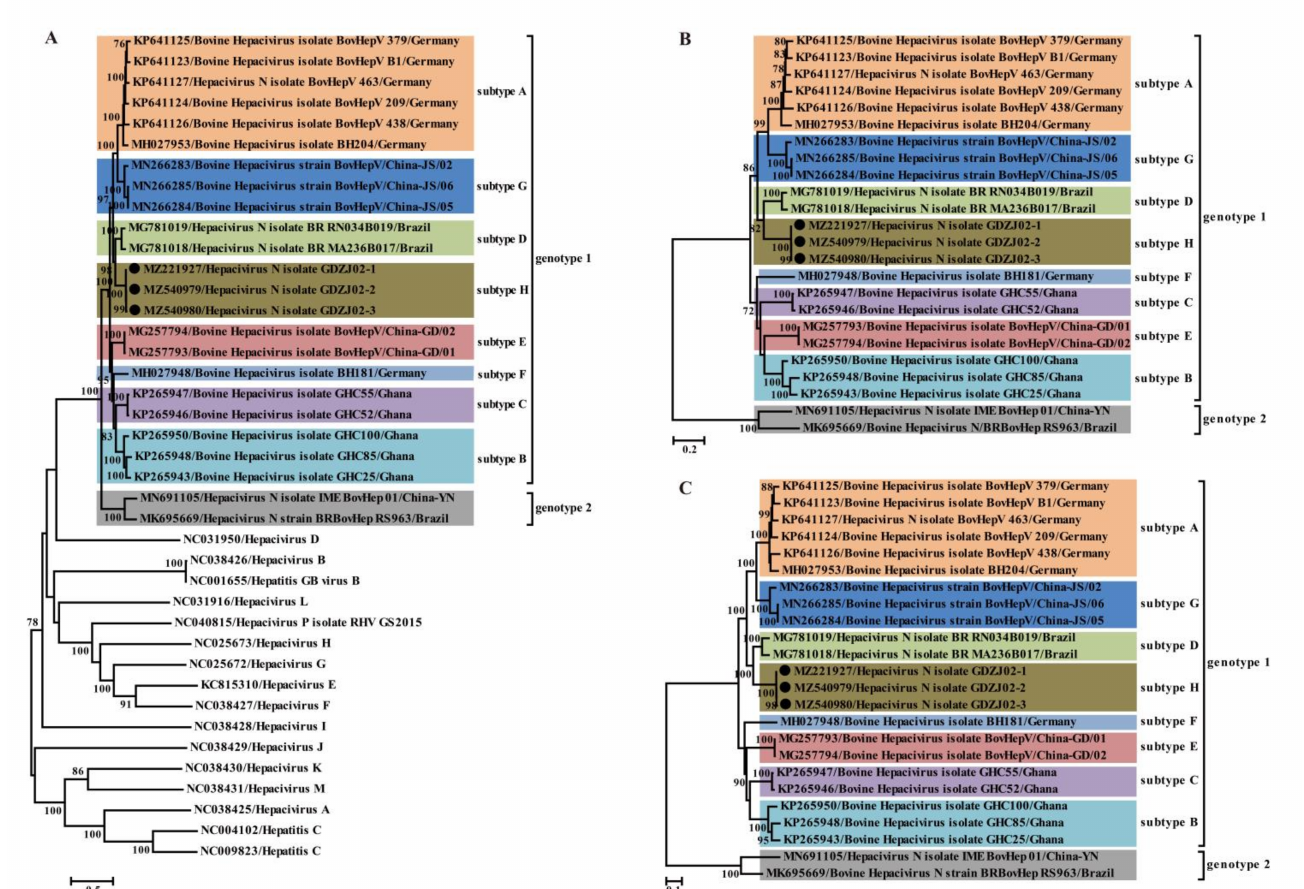
Figure 3. Phylogenetic analysis based on the nucleotide sequences of complete polyprotein-coding region ( A ), NS3 ( B ) and NS5 ( C ) of hepaciviruses including the newly identified sequences and other reference sequences retrieved from GenBank. The trees were constructed based on the maximum likelihood method implemented in PhyML v3.0, and mid-point rooted for clarity and the scale bar represents the number of nucleotide substitutions per site. Bootstrap values were calculated with 100 replicates of the alignment, and only bootstrap values > 70% are shown at relevant nodes. GenBank accession numbers are followed by the name of hepacivirus strains. Black dots indicate the BovHepV determined in this